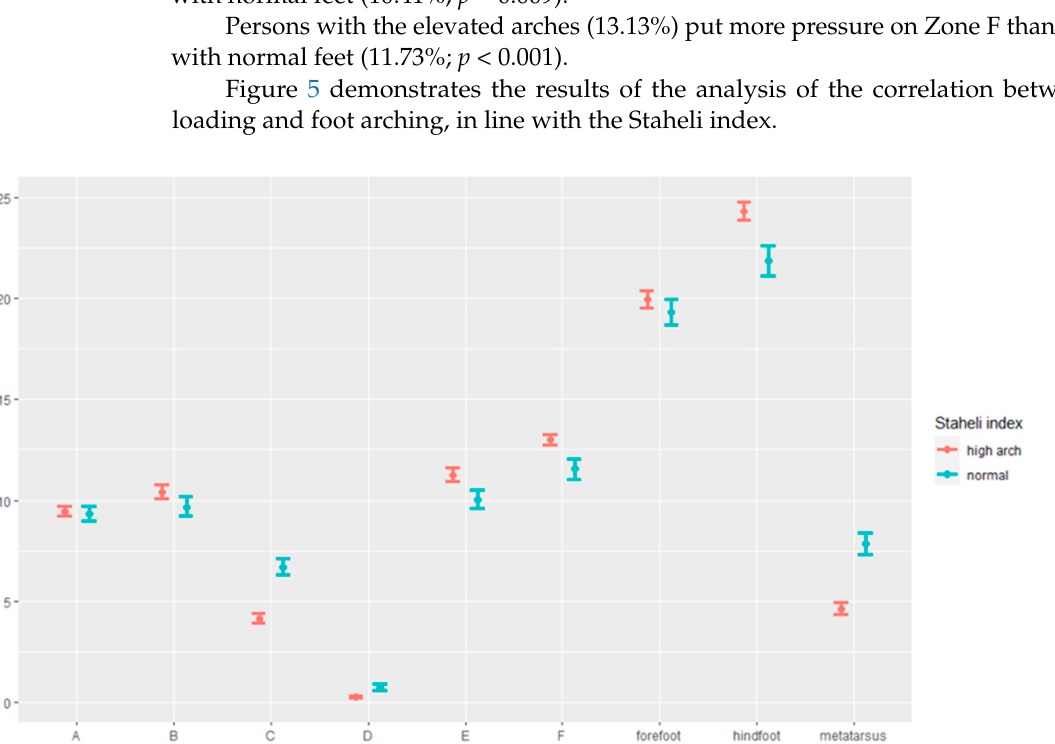
Figure 4. The dependence between foot loading under the static conditions and Chippaux–Smirak index. Persons with the elevated arches (3.86%) put less pressure on Zone C than the ones with normal feet (6.47%; p < 0.001). Persons with the high-arched feet (3.86%) put less pressure on Zone C than the ones with flat feet (7.86%; p < 0.001). Persons with the elevated arches (0.24%) put less pressure on Zone D than the ones with normal feet (0.65%; p < 0.001). Persons with the high-arched feet (0.24%) put less pressure on Zone D than the ones with flat feet (1.41%; p < 0.001). with normal feet (10.41%; p = 0.009).